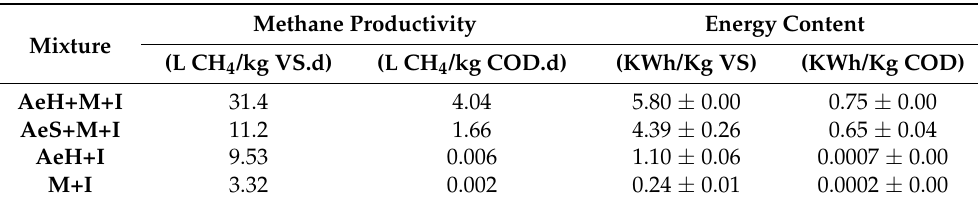
Table 3. Methane productivity and energy potential estimated at the end of the anaerobic digestion for microalgae fermentation wastes and mixtures used as feedstock.